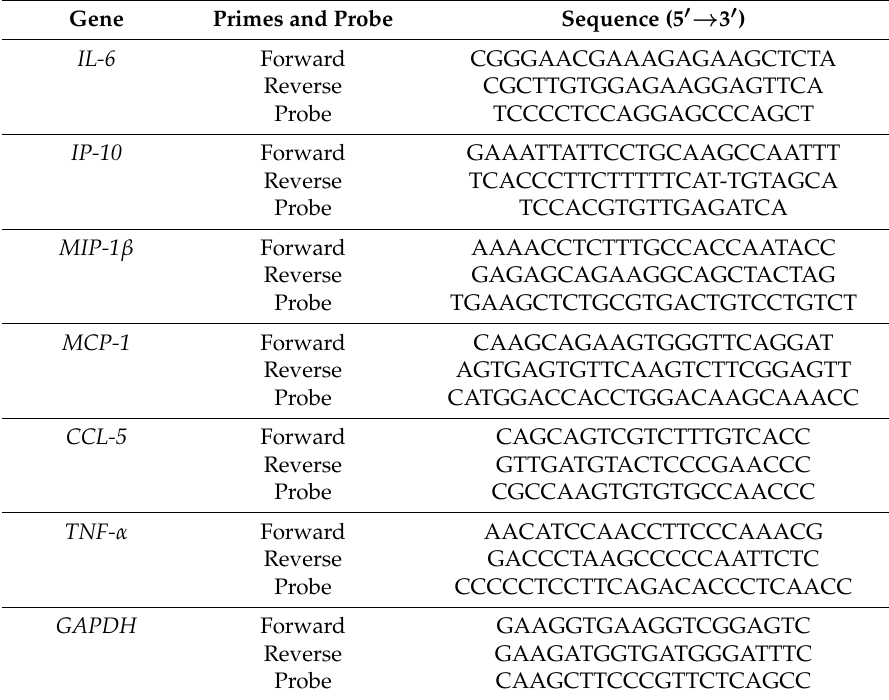
Table 3. Primers and probe sequences for qRT-PCR. Gene Primes and